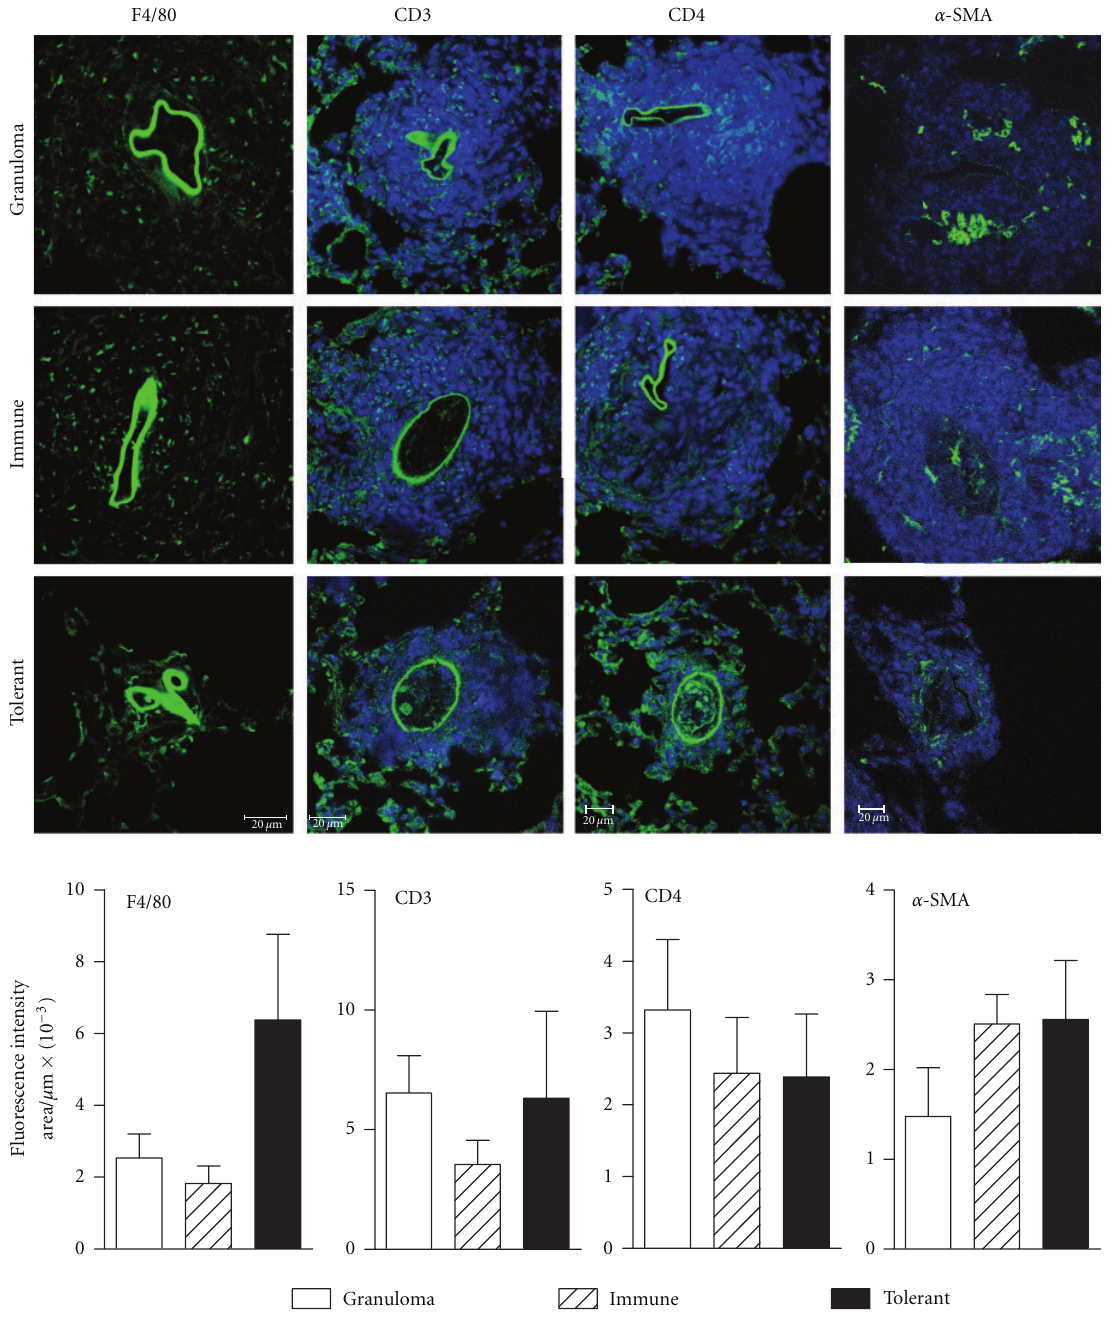
Figure 4: Cell subsets in pulmonary granulomas 18 days after i.v. egg injection. Immunolocalization using specific antibodies followed by secondary antibodies coupled with fluorescein (green) and nuclear counterstainig with 4 (cid:5) 6-diamidino-2-phenylindol (blue), 18 days after i.v. eggs injection. Confocal microscope images were captured with a 63X objective, and the graphs represent the green fluorescence intensity (the sum of gray values of all pixels divided by the area (in μ m 2 ) × 10 − 3 ) of expression of F4/80 (macrophages), CD3 (T-lymphocytes), CD4+ cells, and α -SMA (myofibroblasts) in nonimmunized mice (granuloma group, open bars), OVA immune controls (hatched bars), and OVA-orally tolerant (black bars). Data represent mean ± SEM of fluorescence intensity of duplicate slides ( n = 5 mice/group). The green autofluorescency of eggs was excluded from all analyses. No significant di ff erence was found between